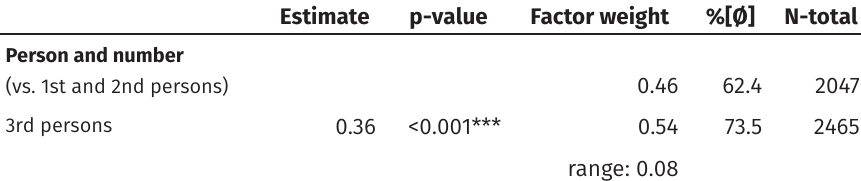
Table 15: The significance of the use of null subject for PERSON AND NUMBER recoded (3rd persons vs. others) (intercept = 1.54; N = 4512; [Ø] =